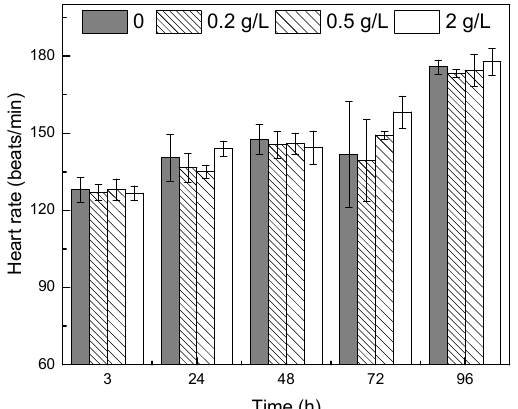
Figure 1. The effect of PAC-MC on the heart rate of newly hatched marine medaka. N = 3, mean ± SD; ANOVA, Tukey.